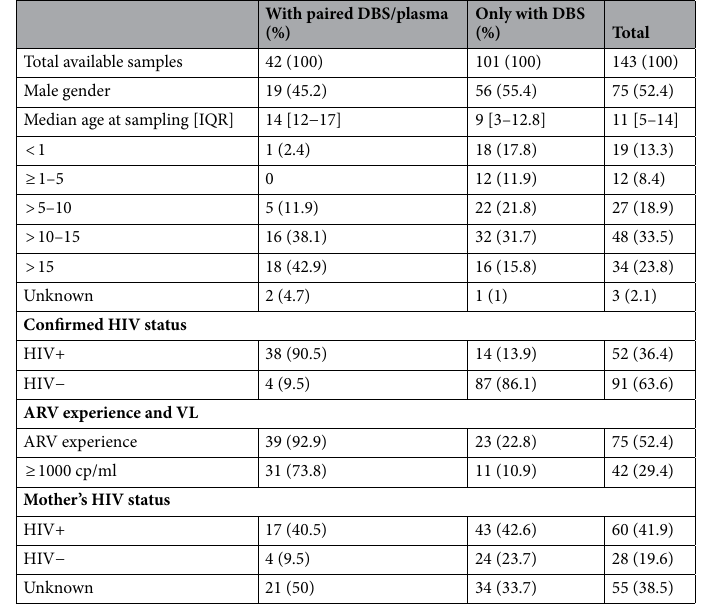
Table 2. Characteristics of the study population from Kinshasa (DRC). Information extracted from clinical files. DRC The Democratic Republic of the Congo, DBS Dried blood samples, IQR Interquartile range, ART Antiretroviral treatment, VL HIV-1 Viral load; Viral load quantified by Cobas®v2.0 (ROCHE), limit of quantification 20cp/ml. Age in years. cp/ml, HIV-1 RNA copies per millilitre of plasma corrected from the DBS cp/dot considering the patient’s haematocrit 22